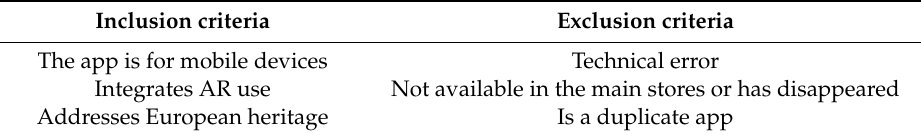
Table 1. Inclusion and exclusion criteria for the final